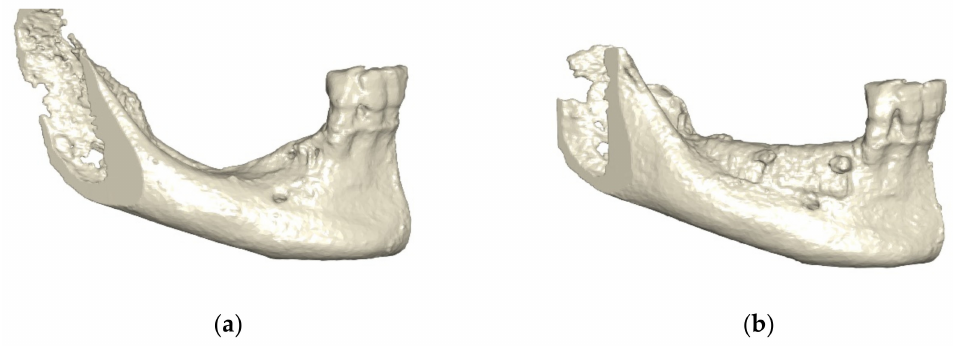
Figure 10. Surgical site of the mandible before ( a ) and 5 months after surgery ( b ).